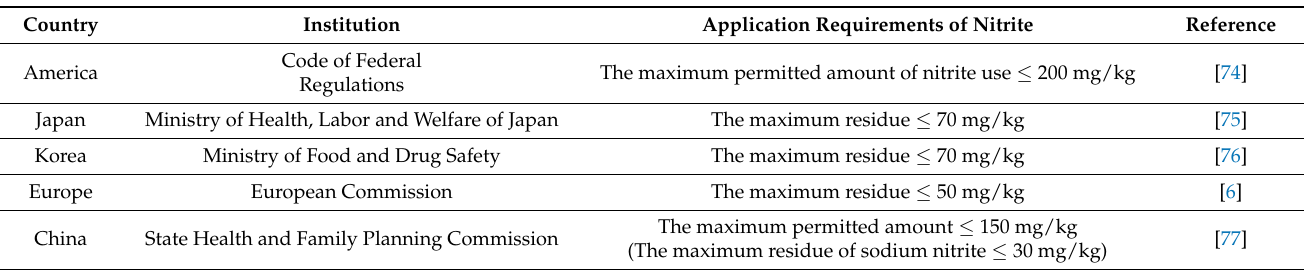
Table 1. Application requirements of nitrite in different countries (only fermented meat